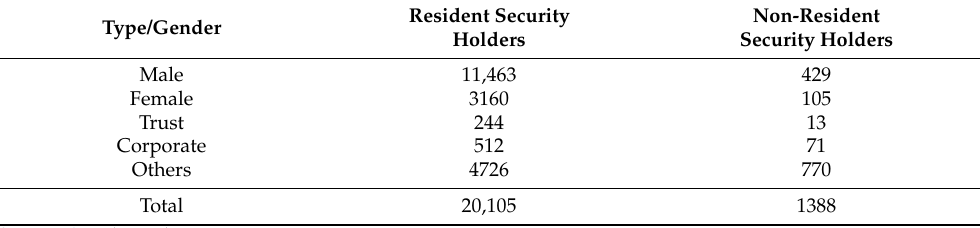
Table 4. Number of Resident and Non-Resident Security Holders by Investor Type and Gender.